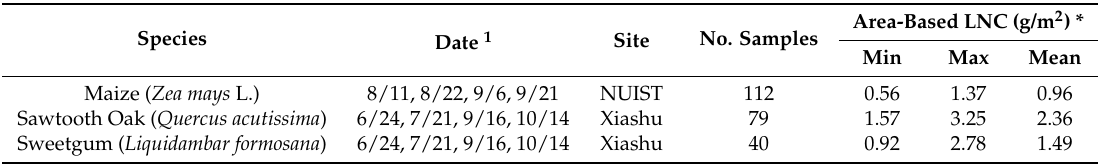
Table 1. The statistics of the sampling data in